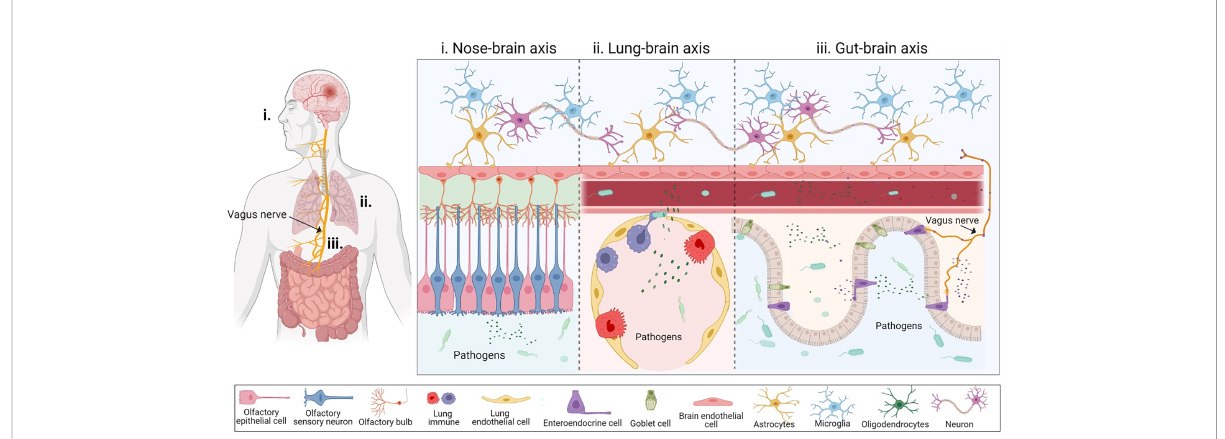
FIGURE 1 The inter-organ communication for pathogens to enter the brain. (i) Nose-brain axis is the fi rst possible pathway that allows infectious agents to invade the CNS. Nasal pathogens can reach the brain by bypassing the blood-brain barrier (BBB) as well as the cerebrospinal fl uid barrier. Infectious agents can invade the CNS via olfactory sensory neurons lying within the mucosal layer. (ii) Lung-brain axis: Pulmonary microbes and their soluble components may directly disrupt the lung alveolar-capillary barrier to enter the blood or interact with the local immune system, subsequently reaching the CNS by disrupting the BBB. (iii) Gut-brain axis serves as another compromising physiological distance connecting the gut and the brain through blood circulation and the vagus nerve. Bacteria and their components can cross the gut-blood barrier during disruption, through bloodstreams where bacteria release their metabolites, which cross the BBB and reach the central nervous system. The vagus nerve is composed of enter-endocrine cells (EECs) located on a gut sensory epithelial layer. The EEC has an extending part called a neuropod cell, which connects the gut lumen and the brain stem, allowing for bi-directional signaling. This fi gure was generated using